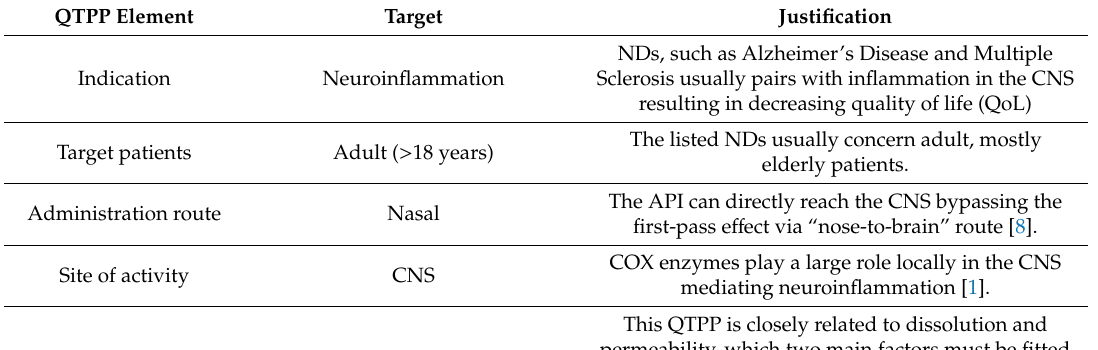
Table 1. Elements of the quality target product profile (QTPP), their targets and